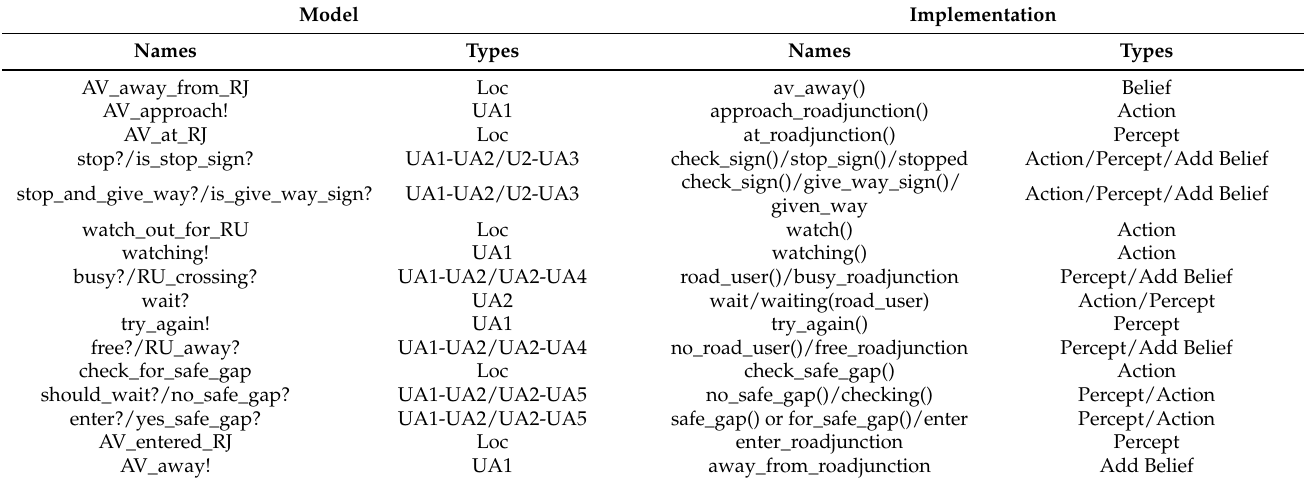
Table 3. Correspondence between Model and